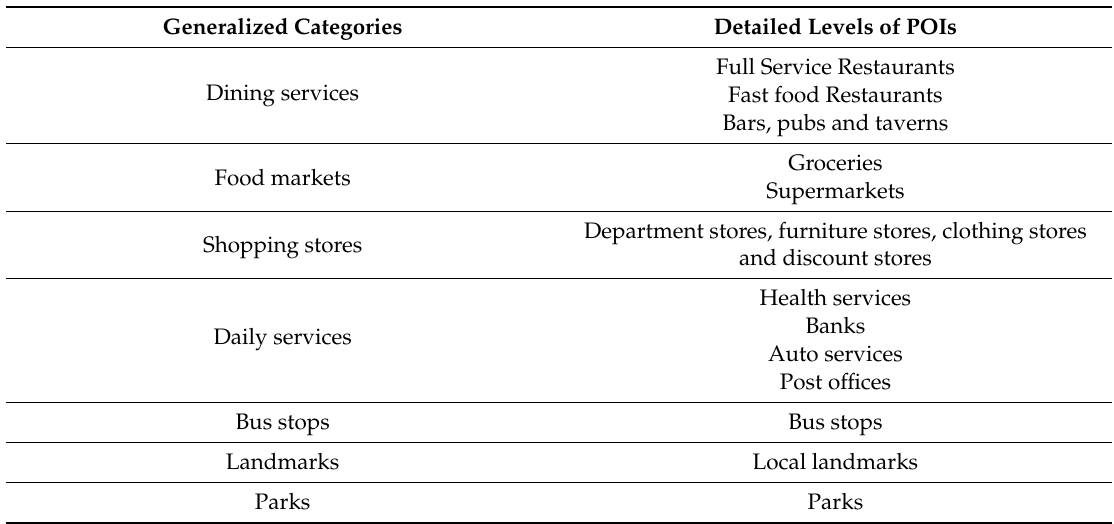
Table 2. Detailed categories of various